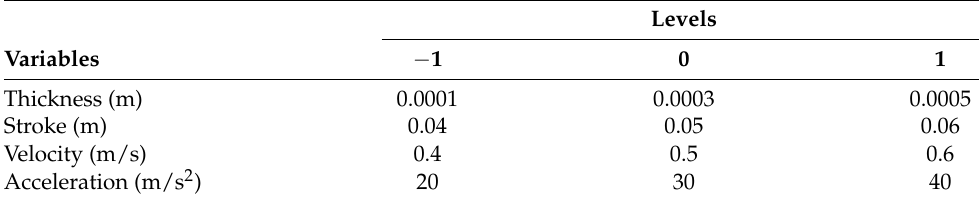
Table 3. The design of response surface